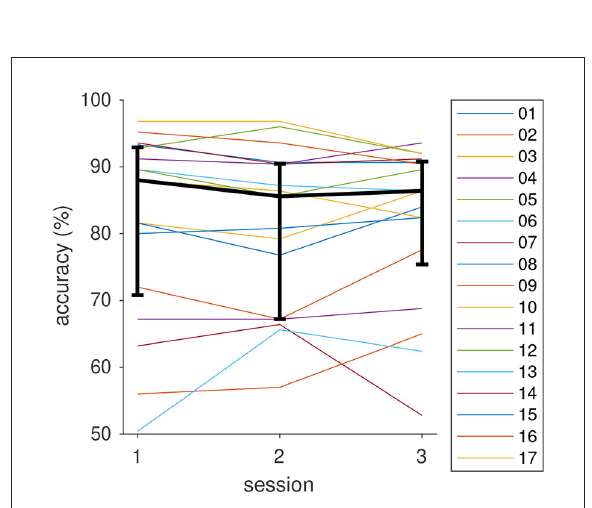
FIGURE8 BCI classification accuracy of the participants in the three sessions. Thick black curve is the median, error bars show the 25 and 75%,